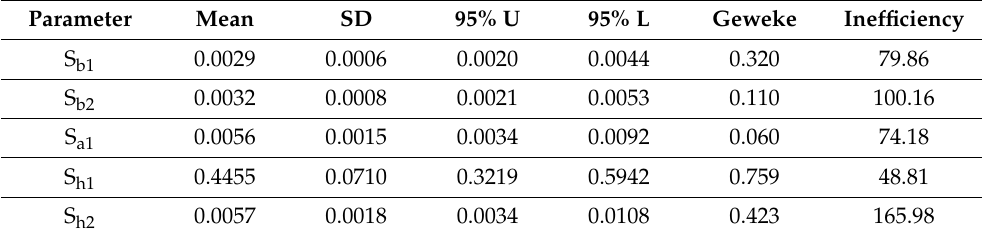
Table 3. Gibbs Sampling Validation Results (based on KB Price Index).